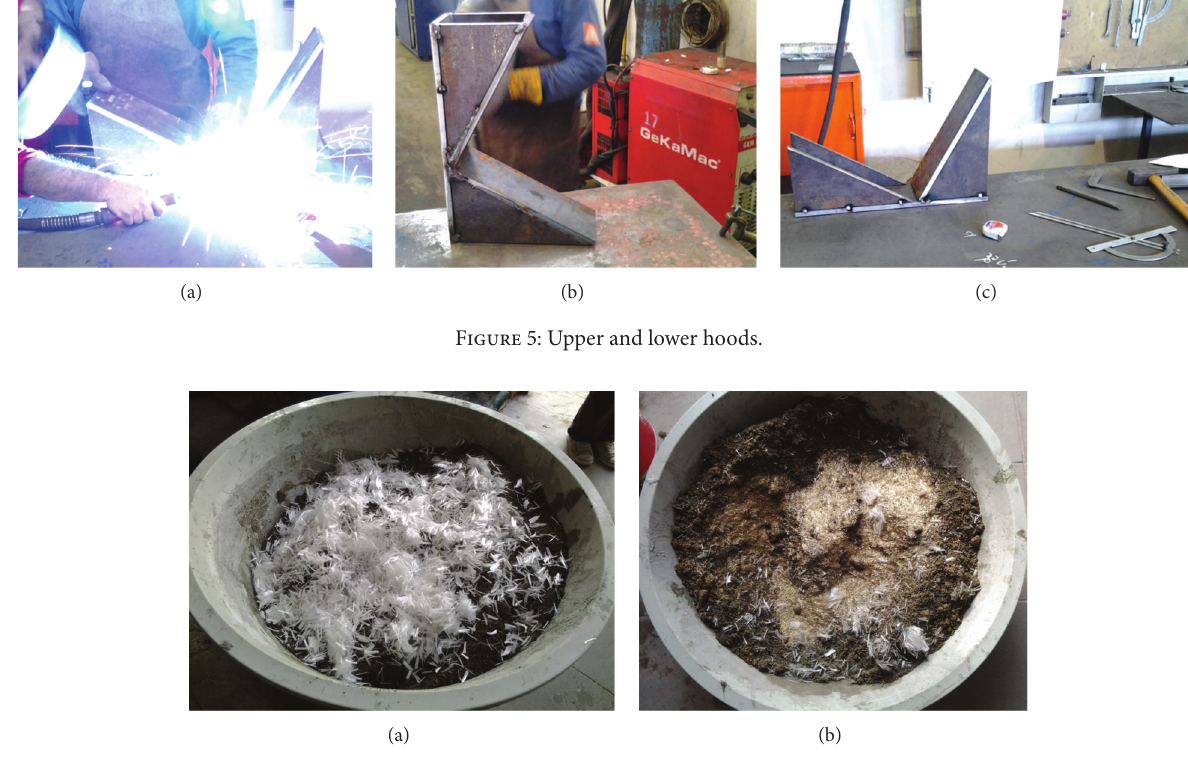
Figure 6: The polypropylene and steel fiber